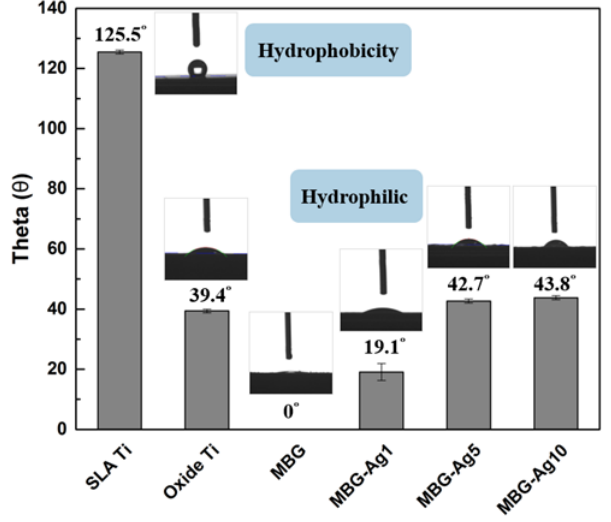
Figure 1. Contact angle measurement of coated specimens (N = 20) ( p <